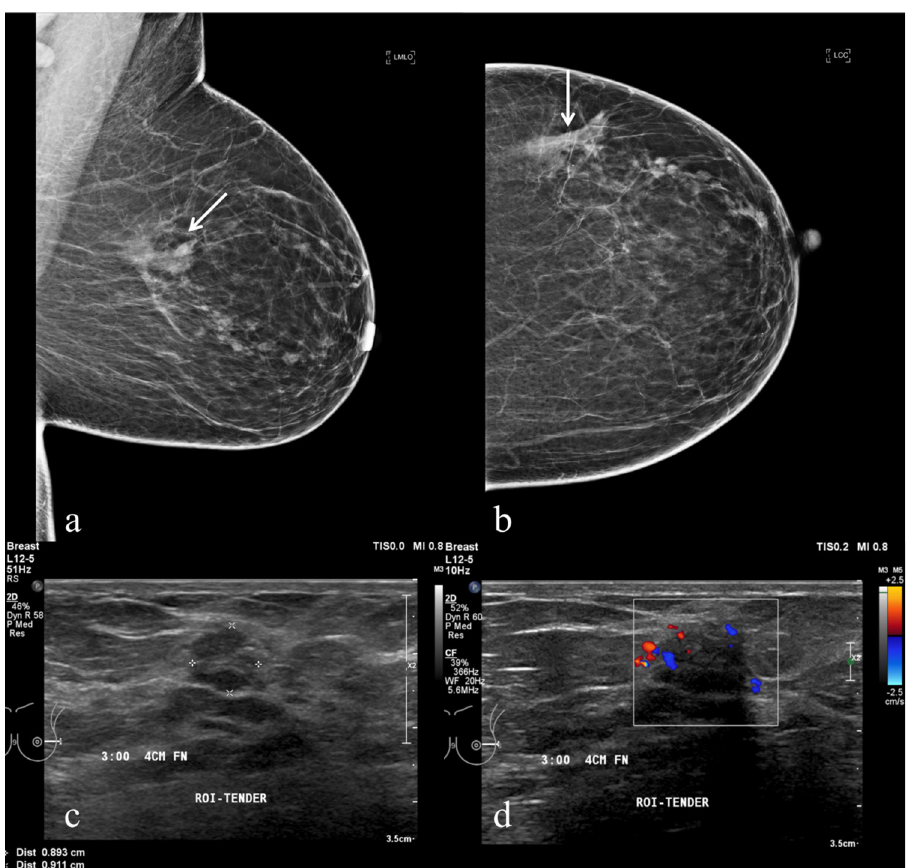
Fig 4. A 49-year-old woman with invasive carcinoma who subsequently underwent mastectomy due to imaging discordance. Left MMG in (A) MLO and (B) CC views showing a spiculated lesion (thin arrow) in the mid outer region with foci of microcalcifications on a background of fatty breast parenchymal pattern (BIRADS density A). Corresponding US in (C) transverse view showing an ill-defined hypoechoic mass in the left 3 o’clock position, measuring 9 x 9mm with the presence of internal vascularity